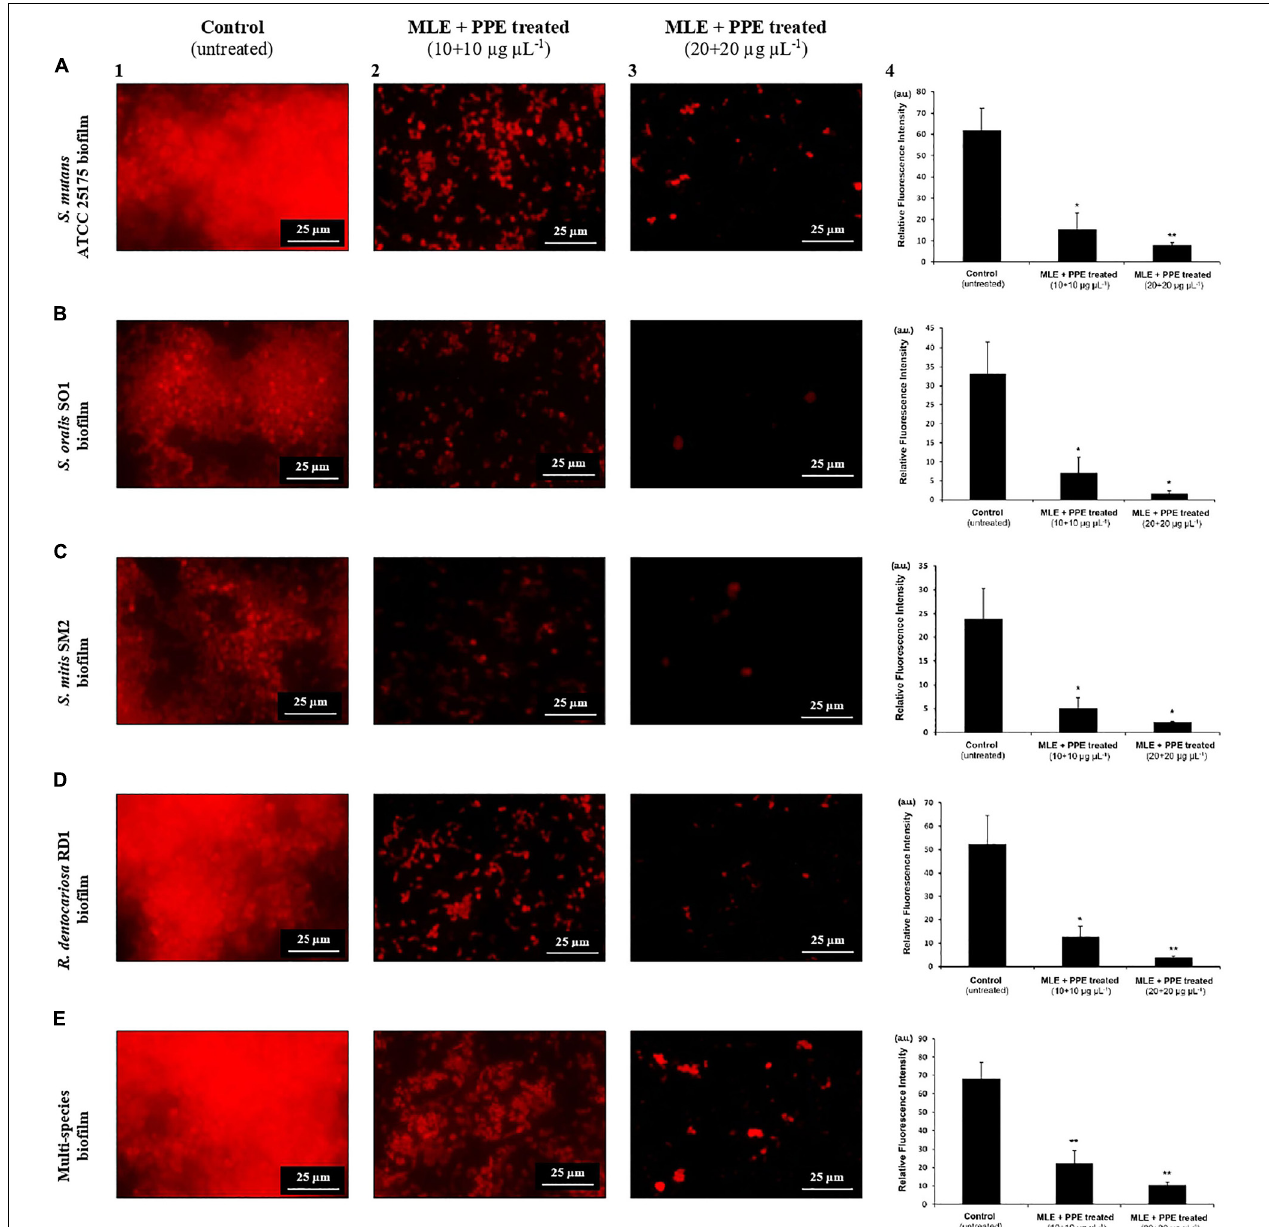
FIGURE 5 | Fluorescence microscopy images of mature S. mutans ATCC 25175 (A) , S. oralis SO1 (B) , S. mitis SM2 (C) , R. dentocariosa RD1 (D) , and multispecies (E) biofilms (1:1:1:1 ratio for each isolate) grown with and without treatment with myrtle extract in binary combination with pomegranate extract. PI staining; MLE + PPE, myrtle leaf 50% ethanolic extract in binary combination with pomegranate peel 50% ethanolic extract (1:1 ratio). Relative fluorescence intensity of biofilm architecture in the S. mutans ATCC 25175 (A4), S. oralis SO1 (B4), S. mitis SM2 (C4), R. dentocariosa RD1 (D4) and multispecies (E4) biofilms is reported in arbitrary unit (a.u.). Data are expressed as mean ± SE. ** p < 0.001,* p < 0.05 compared to the control